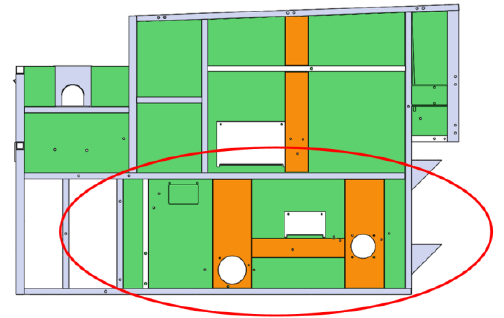
Figure 3. Threshing frame.